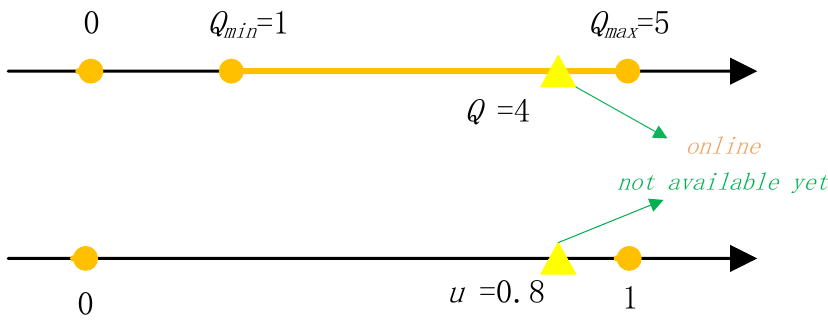
Figure 3. Difference between binary and semi-continuous